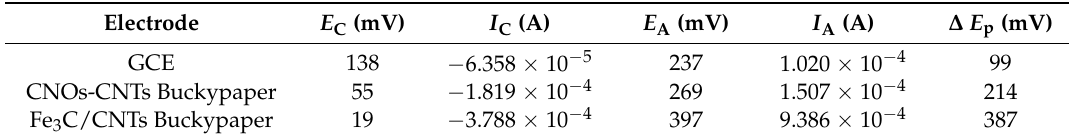
Table 1. Cyclic voltammetry (CV) results obtained for GC, α -, γ -Fe/CNTs/CNOs electrodes and Fe 3 C/CNTs